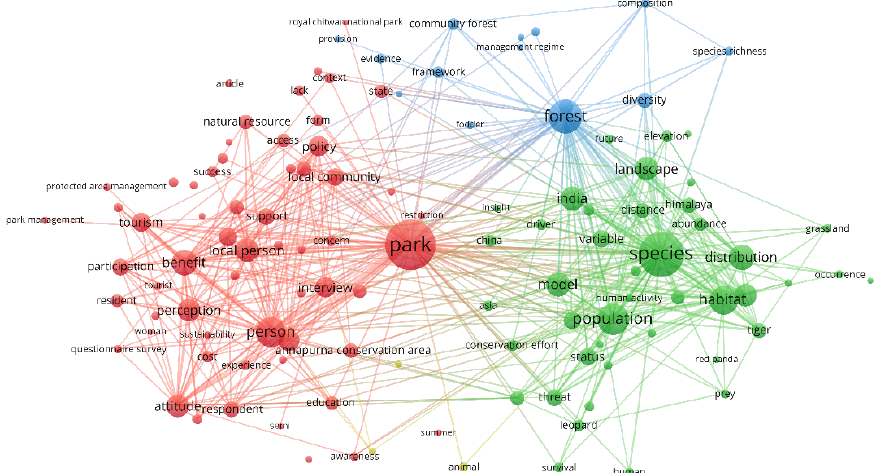
Figure 9. Mapping of “Protected Areas”.